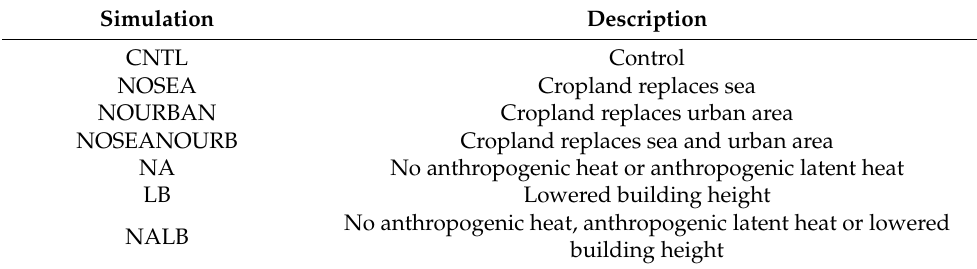
Table 1. Description of control and sensitivity simulations.